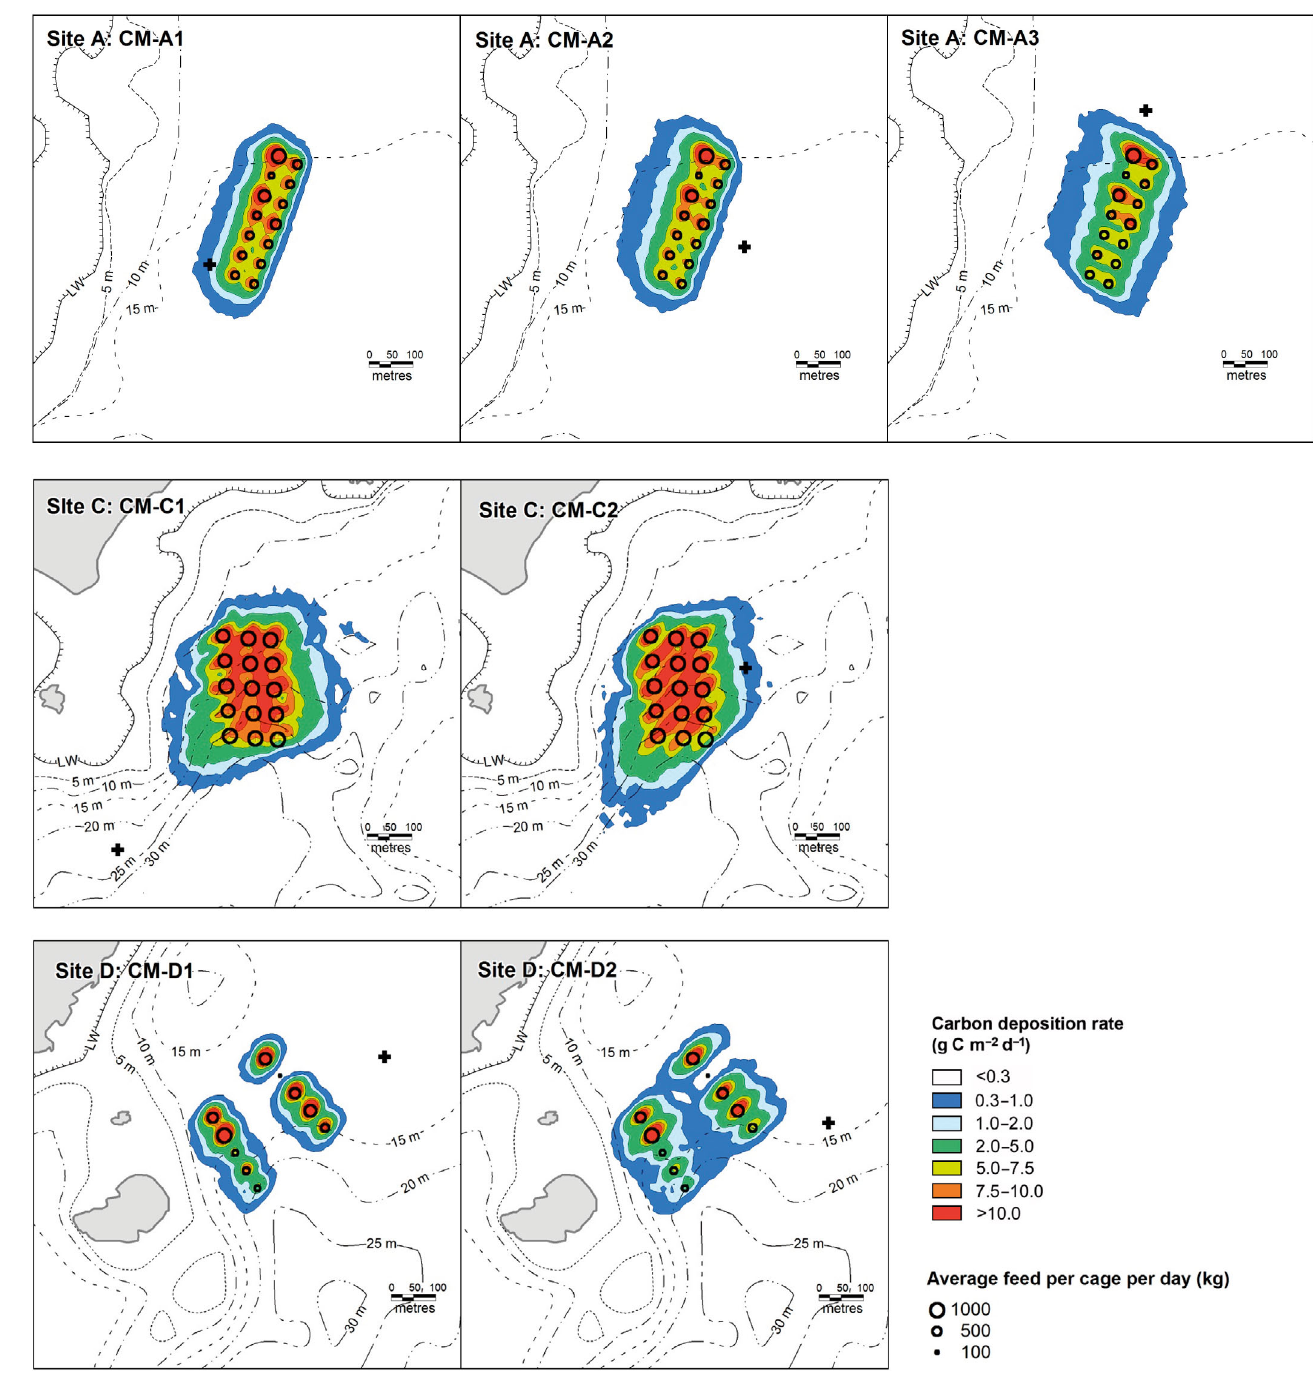
Fig. 3. Contour plots of DEPOMOD-predicted carbon deposition rates at 6 salmon farms in southwestern New Brunswick (SWNB), Canada, without resuspension. The plots show model runs using current velocity data from 2 to 3 current meter (CM) deployments at each site ( + ) and average daily feeding rates during 1 mo periods including the date of sediment sampling. At Site G, the current meter deployments were prior to the cage layout at the time of sampling (at the time of the de ployments, the cages were be tween the 2 m locations). Circles indicate cage locations, with circle sizes proportional to the average daily feeding rate. Background carbon deposition rates in SWNB are reported to be <0.3 g C m −2 d −1 (Hargrave 1994). Each plot shows a 1 × 1 km area, representing the model domain. Depths are below normal lowest tide